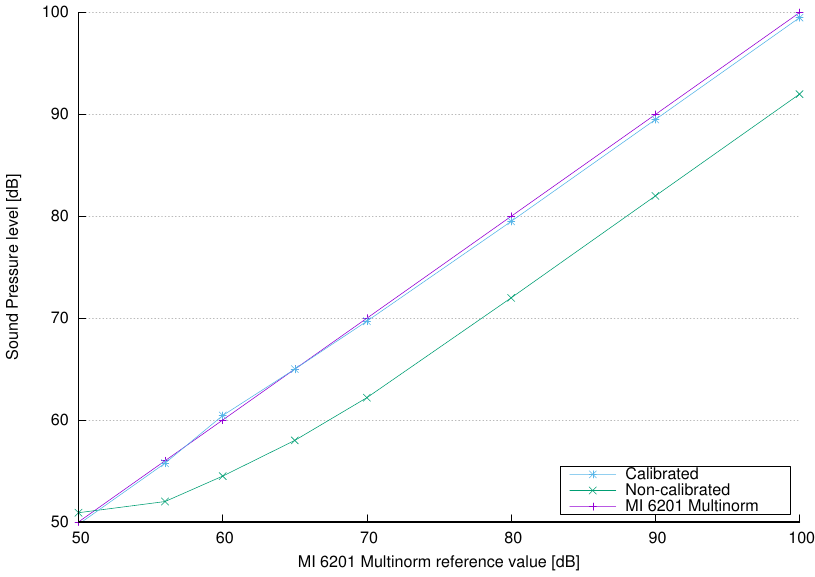
Figure 11. The calibration measurements and the fitting curve. The horizontal axis represents the sound pressure levels obtained with the MI 6201 MULTINORM sound meter, and the vertical axis represents the measured sound pressure levels before and after